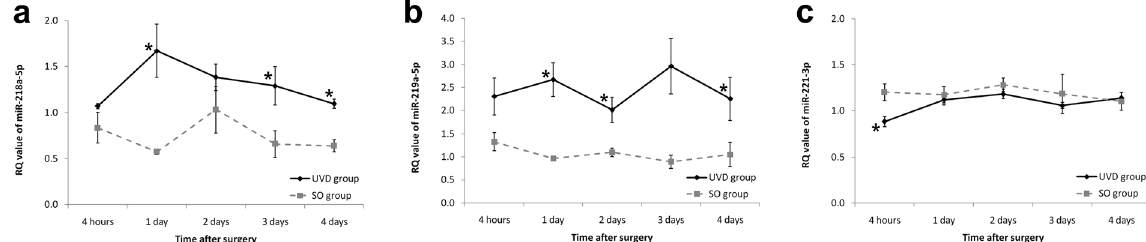
Figure 2. qRT-PCR of candidate miRNAs. Fifty SD rats were divided into two groups: the UVD group underwent unilateral labyrinthectomy and the SO group underwent a sham operation. MVNs were harvested at 4 h and 1, 2, 3, and 4 d following surgery. qRT-PCR was performed for miR-218a-5p ( a ) 219a-5p ( b ) and 221-3p ( c ). The differences in RQ values between the UVD and SO groups were analyzed at each timepoint. miR-218a-5p, 219a-5p, and 221-3p showed significant differences in RQ values between the UVD and SO groups at more than one timepoint. * p < 0.05 between the groups with the Mann–Whitney test. The error bars indicate standard error. qRT-PCR, quantitative reverse transcription-PCR; SD, Sprague–Dawle; UVD, unilateral vestibular deafferentation; SO, sham operation; MVN, medial vestibular nucleus; RQ, relative